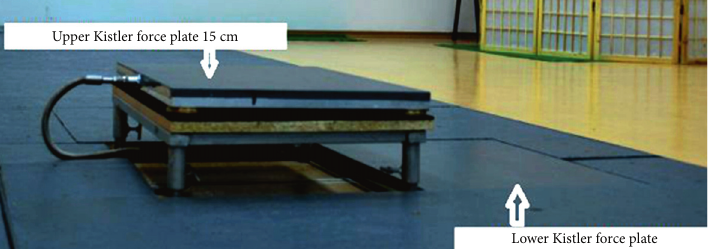
Figure 1: Experimental set-up. The fi rst plate was embedded in the fl oor surface, and the second was fi xed to a stable platform 15cm above the fi rst